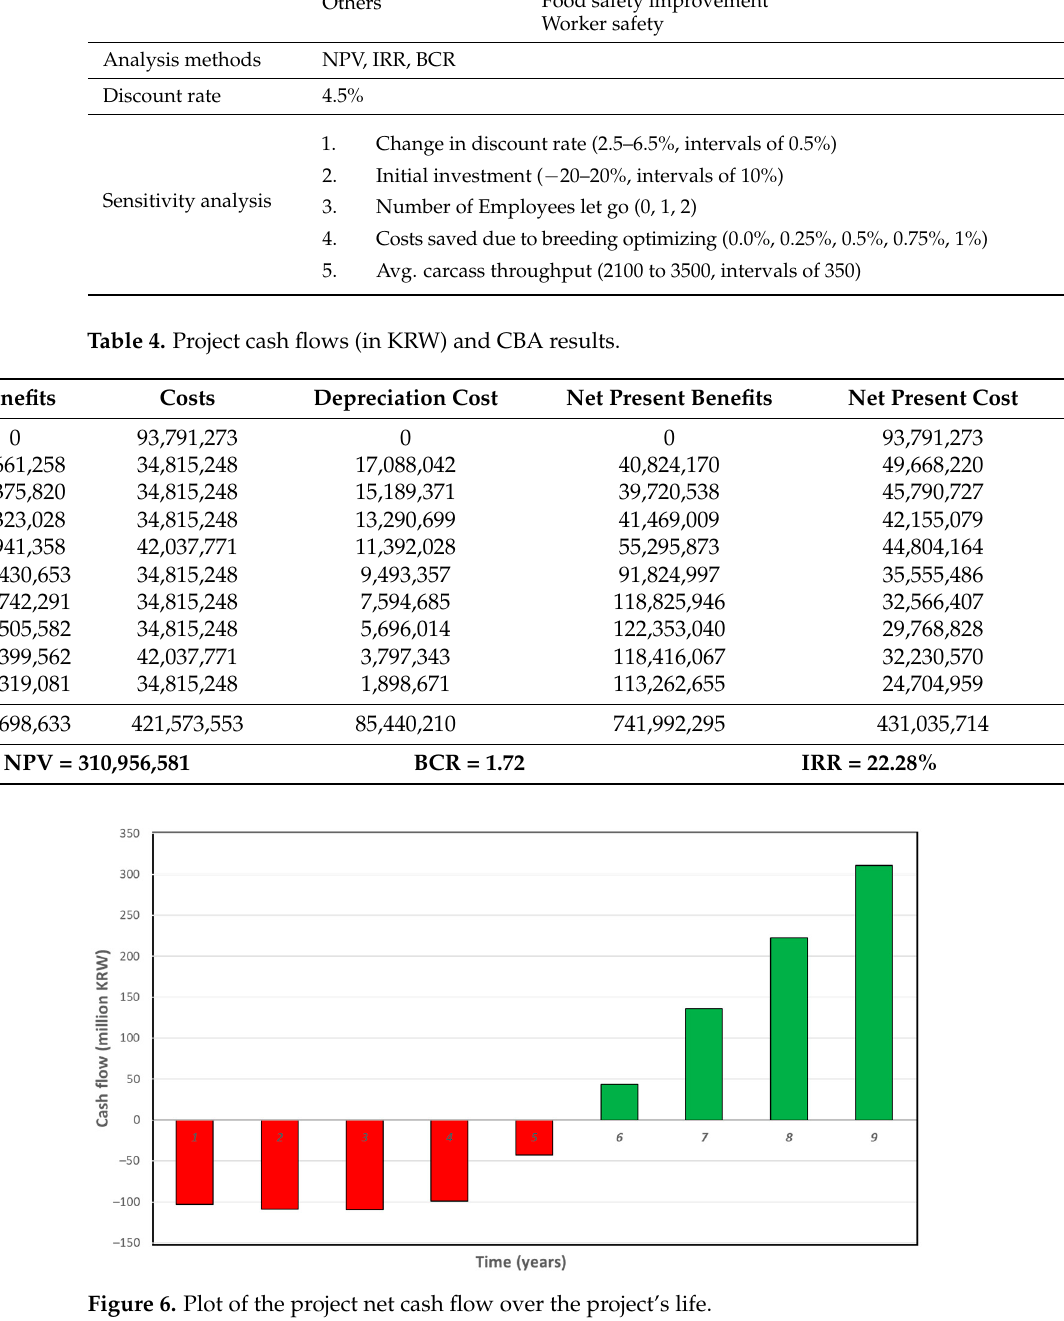
Table 4. Project cash flows (in KRW) and CBA results.